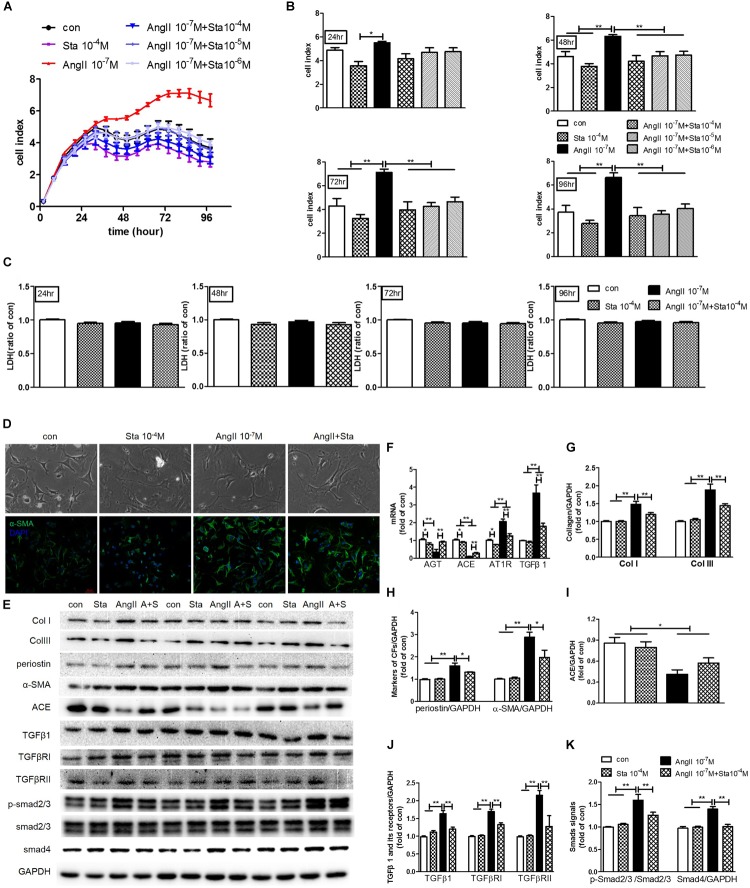
Sta suppressed AngII activated cardiac fibroblast-myofibroblast transition via inhibiting AngII/TGFβ1 fibrogenic axis. CFs were treated with or without AngII (10−7 M) and different dosages of Sta (10−6–10−4 M) for up to 96 h. (A) Representative cell proliferation curves recorded by xCELLigence TRCA system in CFs. (B) Statistics of cell index at 24, 48, 72, and 96 h in CFs. (C) Statistics of LDH content at 24, 48, 72, and 96 h in CFs. (D) Representative microscopic images in light field of CFs (upper row), and fluorescence (lower row) images for α-SMA and DAPI staining in CFs after drug treatments for 48 h. (E) Representative western blots and statistics of Col I, III, periostin, α-SMA, ACE, TGFβ1, TGFβRI, TGFβRII, phosphorylated and total Smad2/3, Smad4 and GAPDH contents in CFs after drug treatments for 48 h. (F) Quantitative real-time PCR of ATG, ACE, AT1R and TGFβ1 in CFs after drug treatments for 48 h. (G–K) Representative western blots and statistics of Col I, III, periostin, α-SMA, ACE, TGFβ1, TGFβRI, TGFβRII, phosphorylated Smad2/3, and Smad4. The data were expressed mean ± SEM. ∗∗P < 0.01; ∗P < 0.05. con, control; Sta, stachydrine; AngII, angiotensin; LDH, lactate dehydrogenase; α-SMA, α-smooth muscle actin; DAPI, 4′,6-diamidino-2-phenylindole; Col I and III, collagen I and III; GAPDH, glyceraldehyde-3-phosphate dehydrogenase; TGFβ1, transforming growth factor β1; TGFβRI, TGFβ receptor I; TGFRII, TGFβ receptor II; p-Smad2/3, phosphorylated Smad2/3; ATG, angiotensinogen; ACE, angiotensin converting enzyme; AT1R, angiotensin type 1 receptor.